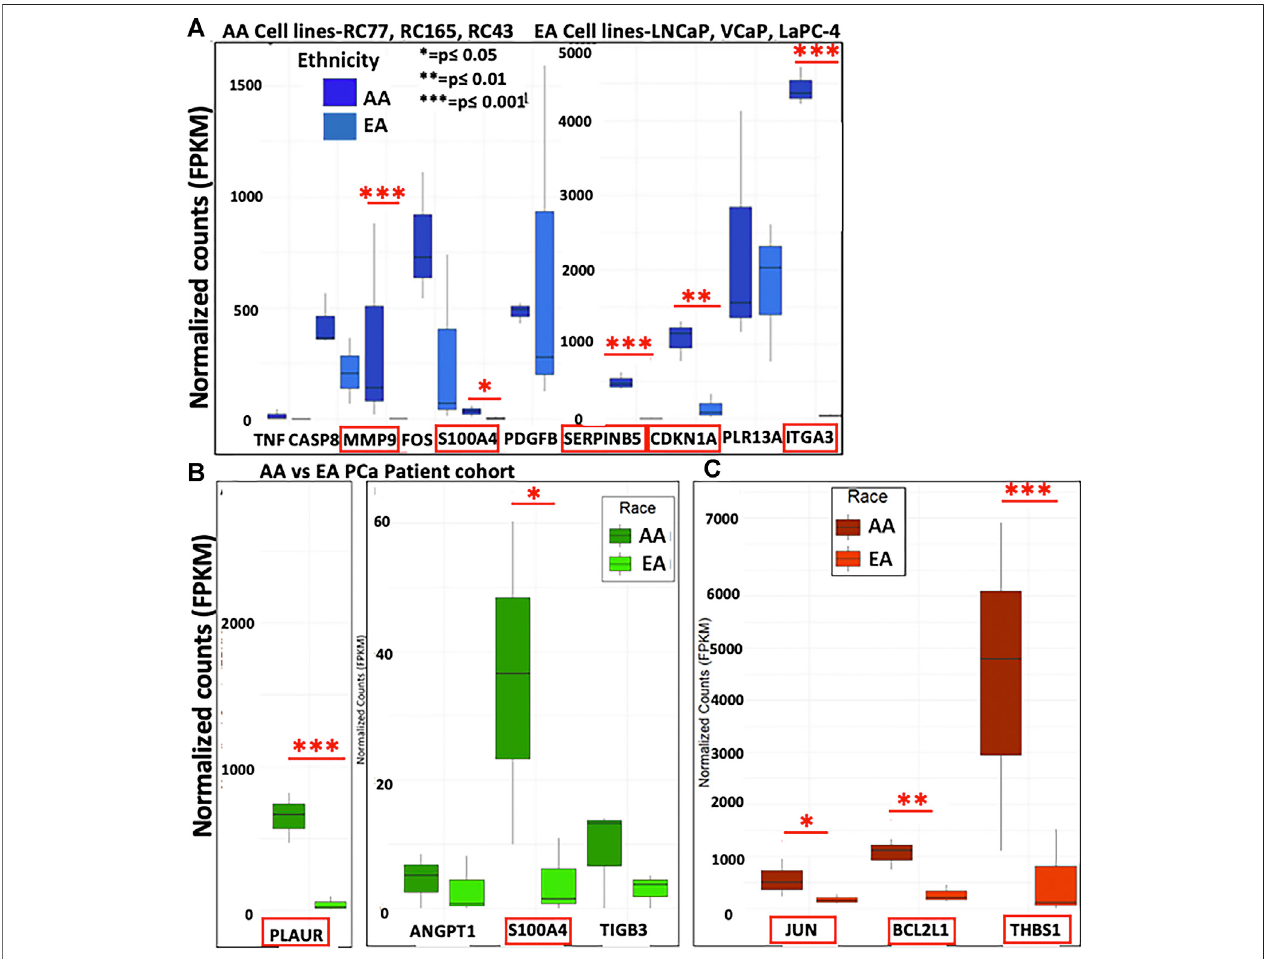
FIGURE 6 | Determination of METRO-TOPO gene expression signatures in cell lines representing EA vs AA patients. (A) Top DEGs for METRO-TOPO dosing (SERPINB5, CDKN1A, MMP9, ITGA3 and S100A4) were differentially expressed signi fi cantly in AA cell line vs EA cell lines (RC77, RC165, RC43 vs LNCaP, VCaP, LaPC4) ( p * (cid:1) p ≤ 0.05, ** (cid:1) p ≤ 0.01, *** (cid:1) p ≤ 0.001). Expression of all these genes were higher in AA compared to EA cell lines. (B) METRO-TOPO genes unique to AI- mCRPC ( p * (cid:1) p ≤ 0.05, ** (cid:1) p ≤ 0.01, *** (cid:1) p ≤ 0.001). Expression of PLAUR and S100A4 was higher in AA compared to EA cell lines. (C) METRO-TOPO gene signatureuniquetocastration-sensitivePCa( p * (cid:1) p ≤ 0.05,** (cid:1) p ≤ 0.01,*** (cid:1) p ≤ 0.001).JUN,BCL2L1andTHBS1expressionlevelswerehigherinAAcellscompared to EA-derived cell